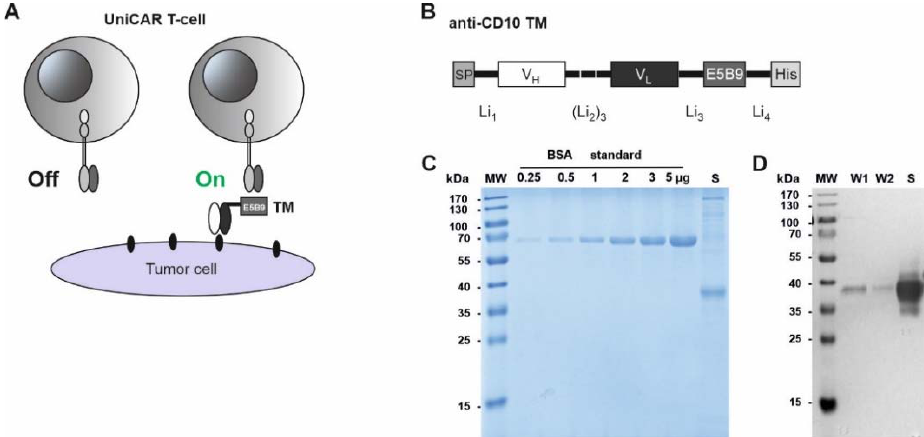
Figure 1. Design and expression of anti ‐ CD10 target module. ( A ) Schematic representation of the UniCAR system; UniCAR T ‐ cells can only be activated in the presence of the target module (TM) and their target cell (On). In the absence of the TM, the UniCAR T ‐ cells are switched off (Off). ( B ) The anti ‐ CD10 TM was obtained by joining the variable light and heavy (V L , V H ) chain domains of CD10 monoclonal antibody (mAb) via peptide linkers followed by fusion of the E5B9 epitope and a hexa ‐ histidine (6xHis) tag. ( C ) The purified TM was analyzed by SDS ‐ PAGE along with bovine serum albumin (BSA) standard, followed by Quick Coomassie ® Stain. ( D ) Alternatively, the separated proteins were blotted on nitrocellulose membrane and detected with mouse anti ‐ penta ‐ His Ab and the reaction of the alkaline phosphatase ‐ conjugated to secondary anti ‐ mouse IgG Ab. W1, W2: washes of Ni ‐ NTA columns after purification; S: sample elution (anti ‐ CD10 TM), MW: Molecular weight marker, Li: Linker, SP: Ig signal peptide..